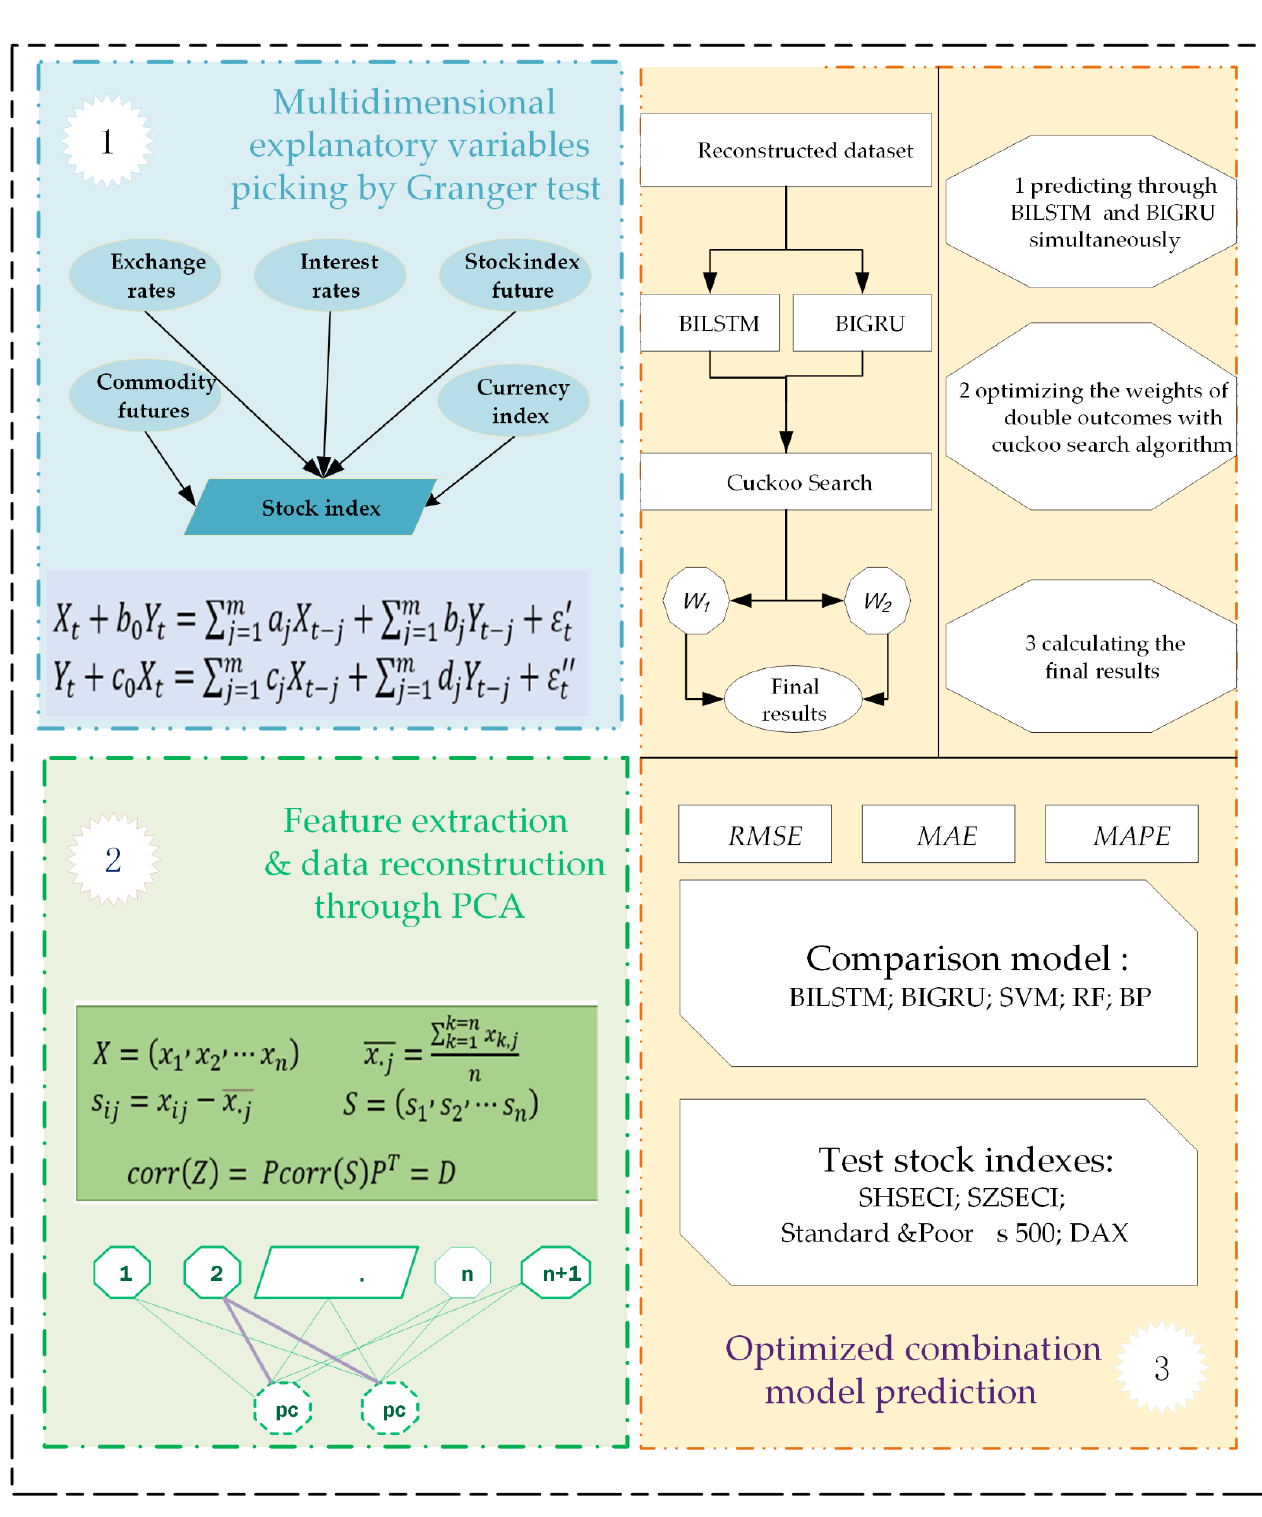
Figure 2. Framework of proposed model.